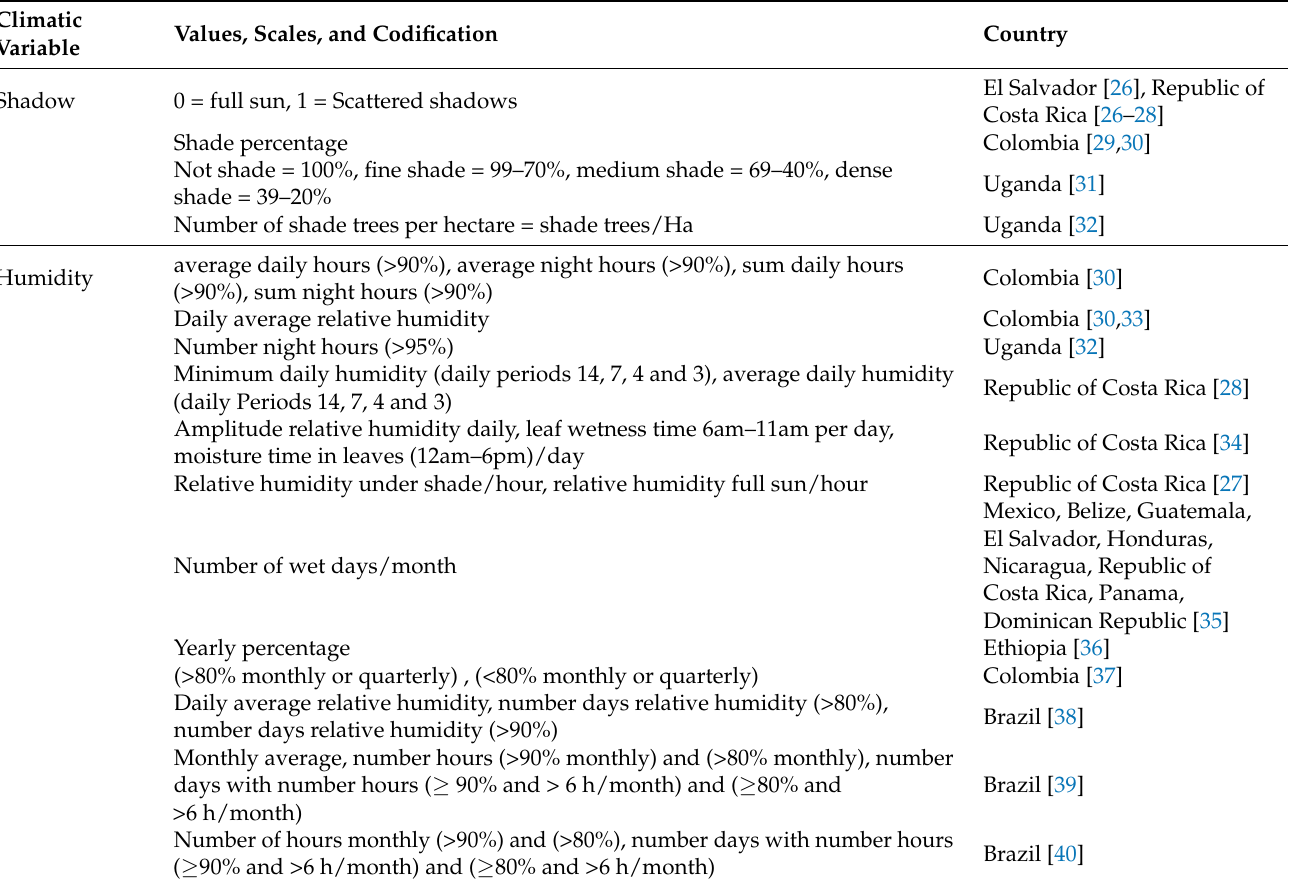
Table 1. Climatic variables considered by country and their respective values, scales, and